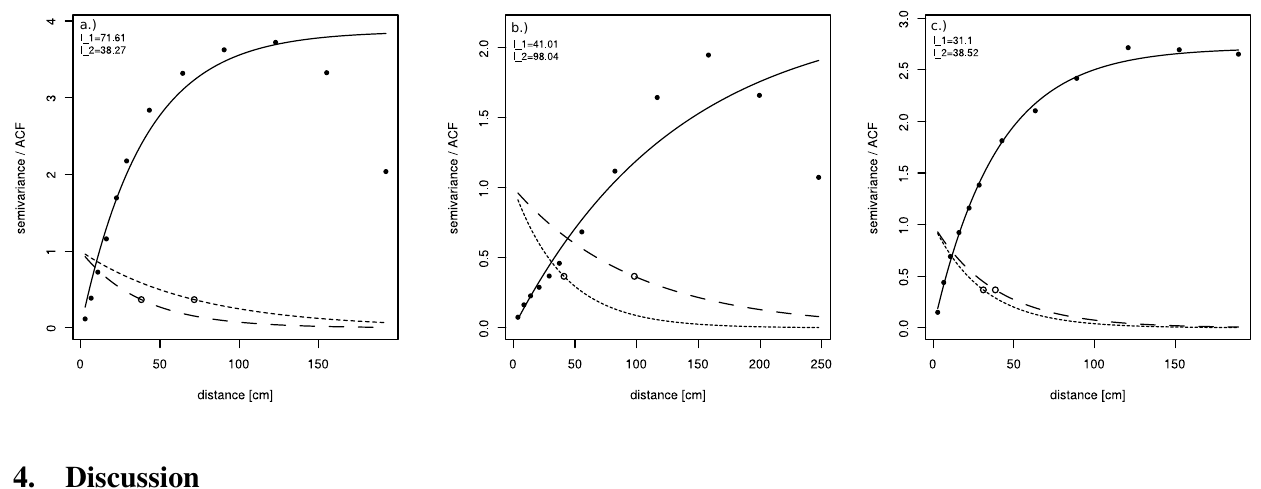
Figure 7. Decomposed two scale roughness pattern for sample plots R12 ( a ), R14 ( b ) and R21 ( c ). Filled dots show the sample variogram and corresponding fitted theoretical variogram (black solid line). Derived autocorrelation function (ACF) ( l coarse dashed line) and corresponding autocorrelation length are indicated by hollow